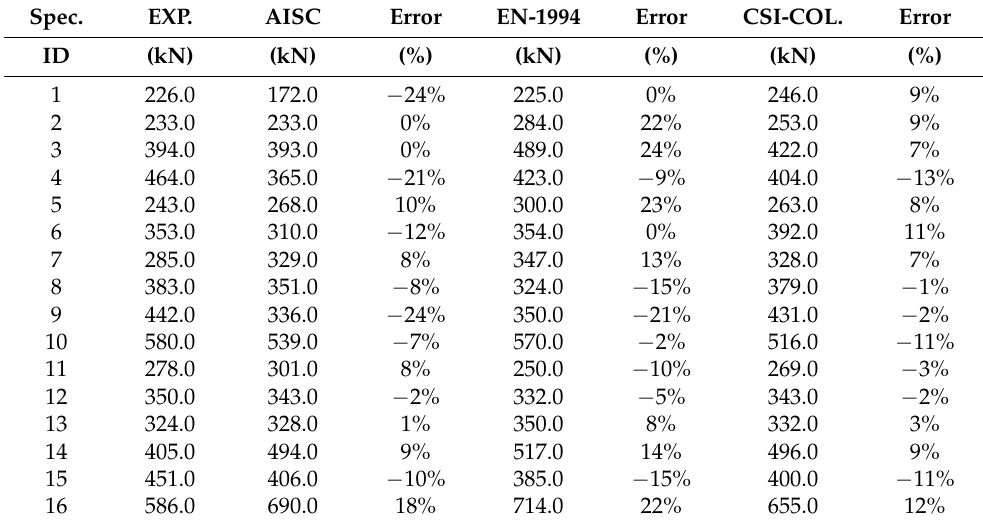
Table 6. Summary of theoretical analysis